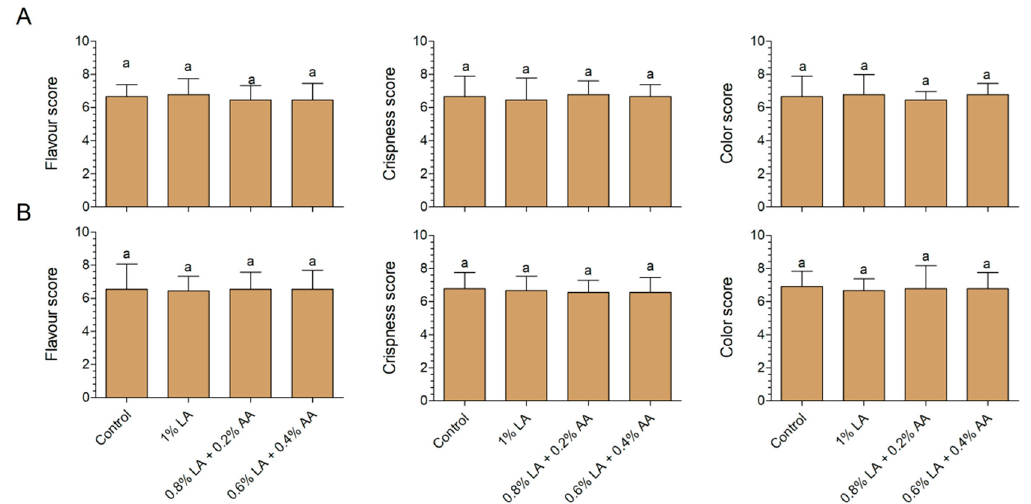
Figure 3. Effects of different combinations of sanitizers on the flavor, crispness, and color of fresh-cut baby spinach ( A ) and arugula ( B ). Different letters above the columns indicate significant differences ( p < 0.05). AA, acetic acid; LA, lactic acid .